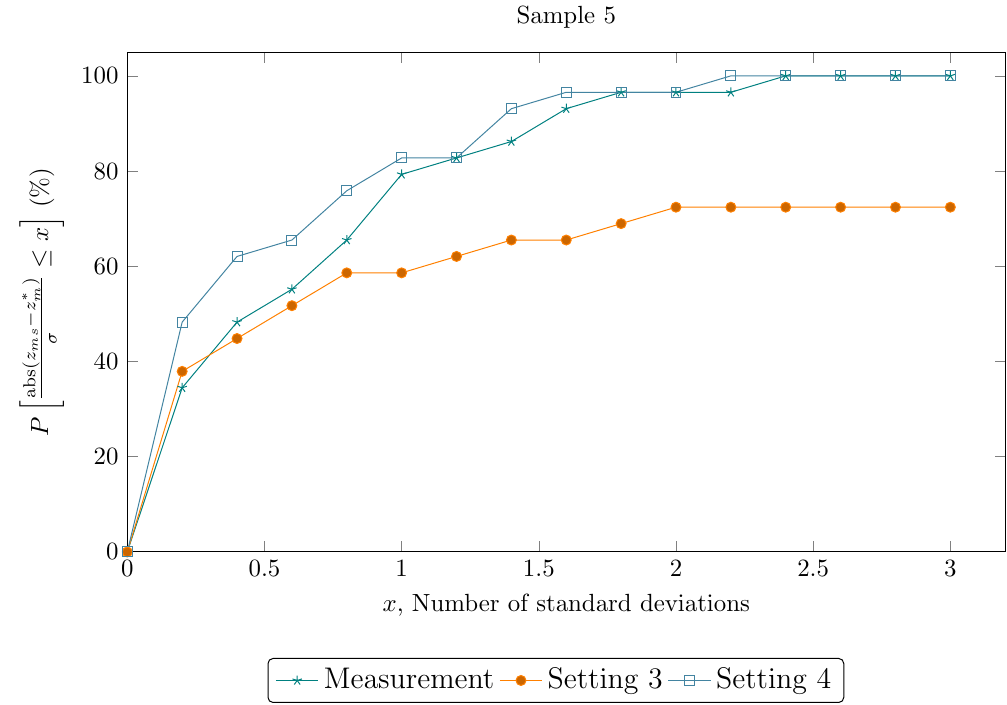
Figure 4. Cumulative distribution function of the variability around the true values for each sample set for the DRPE results of settings 3 and 4.